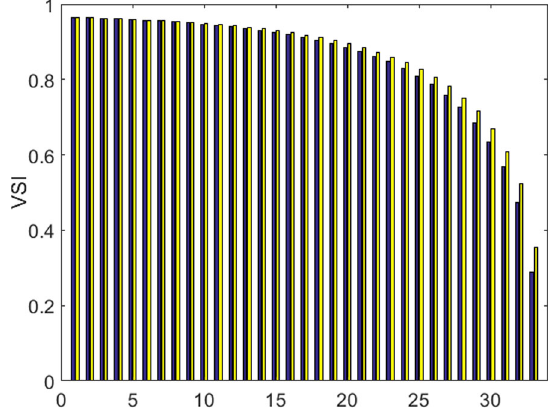
Fig. 13 VSI as indicator of weakest bus